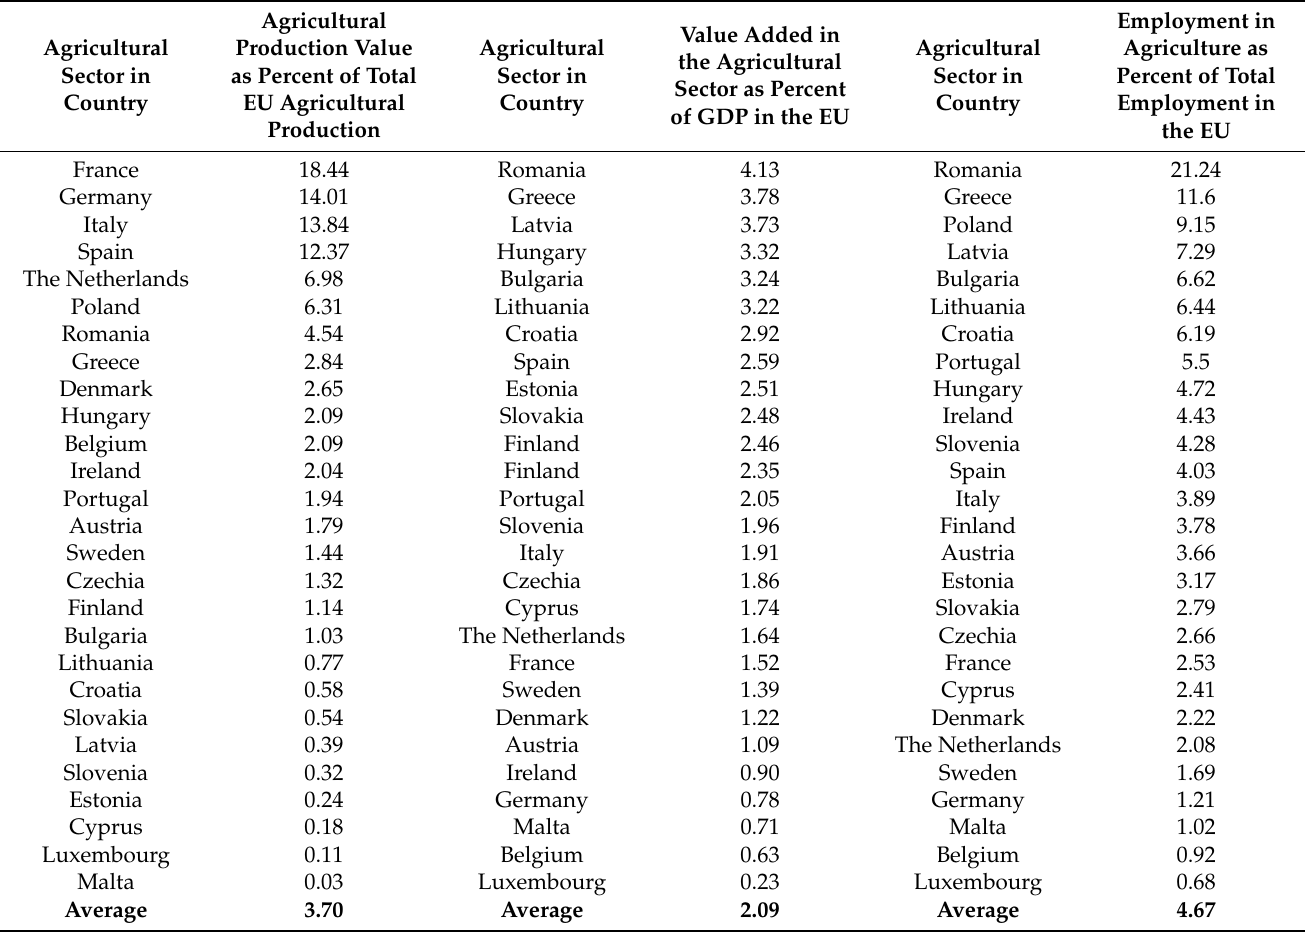
Table 2. The role of agriculture in the economy of